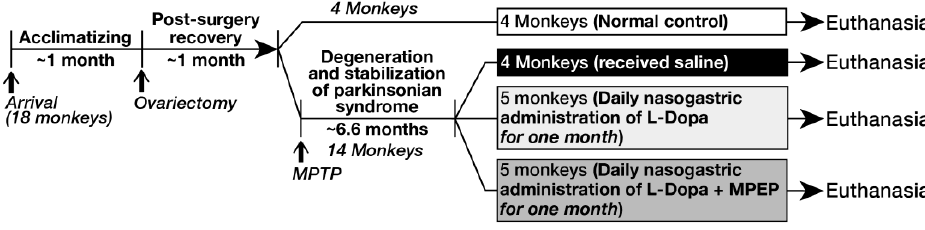
Figure 1. Timelines for animal lesion and treatments.